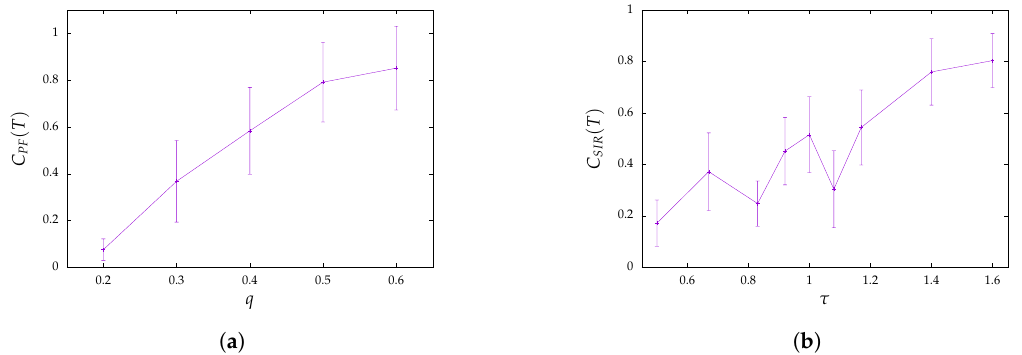
Figure 2. Comparison of total coverage between probabilistic flooding and the SIR epidemic: ( a ) probabilistic flooding coverage C PF ( T ) by probability q ; ( b ) SIR epidemic model coverage C SIR ( T ) by reproduction number τ